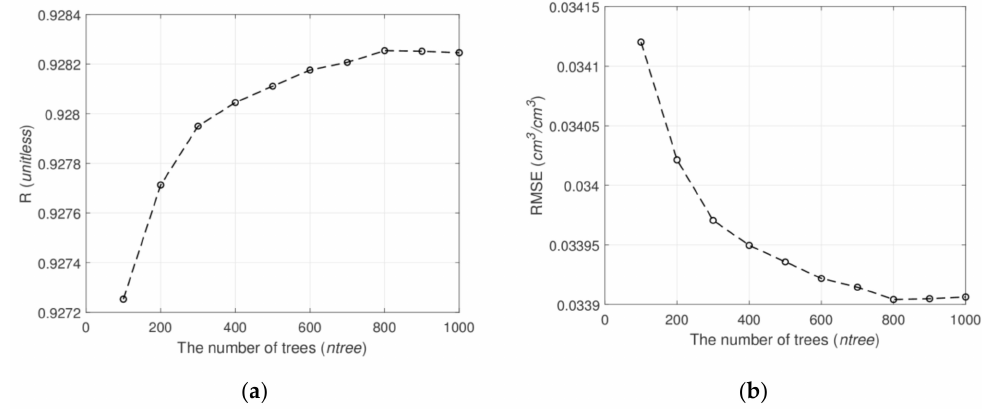
Figure 8. Effects of ntree parameter on the SM retrieval performance. ( a ) R and ( b ) RMSE.